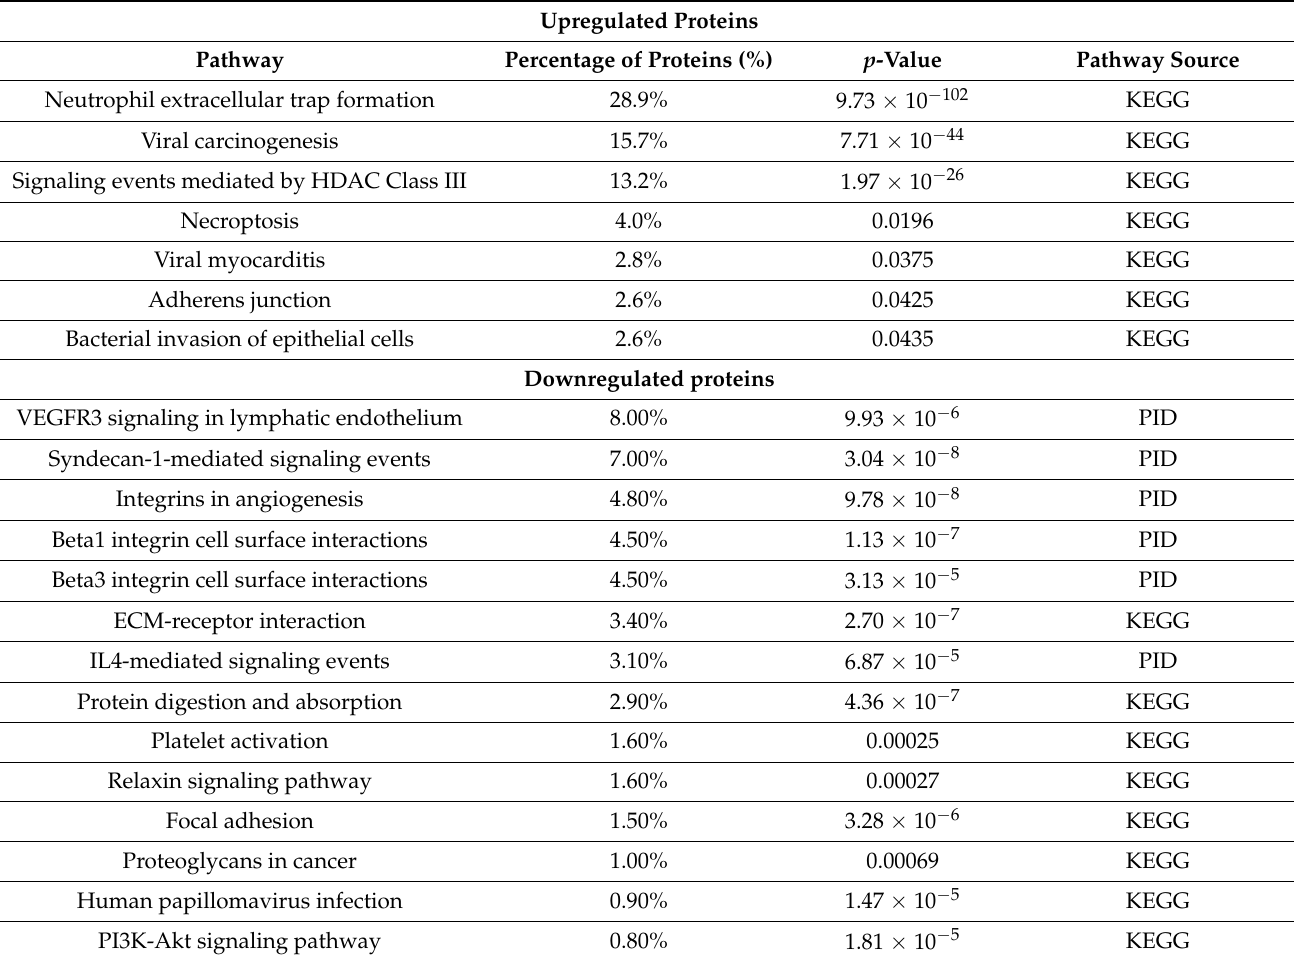
Table 4. Pathways involved in upregulated and downregulated proteins in SCC vs. normal cervix group using ConsensusPathDB